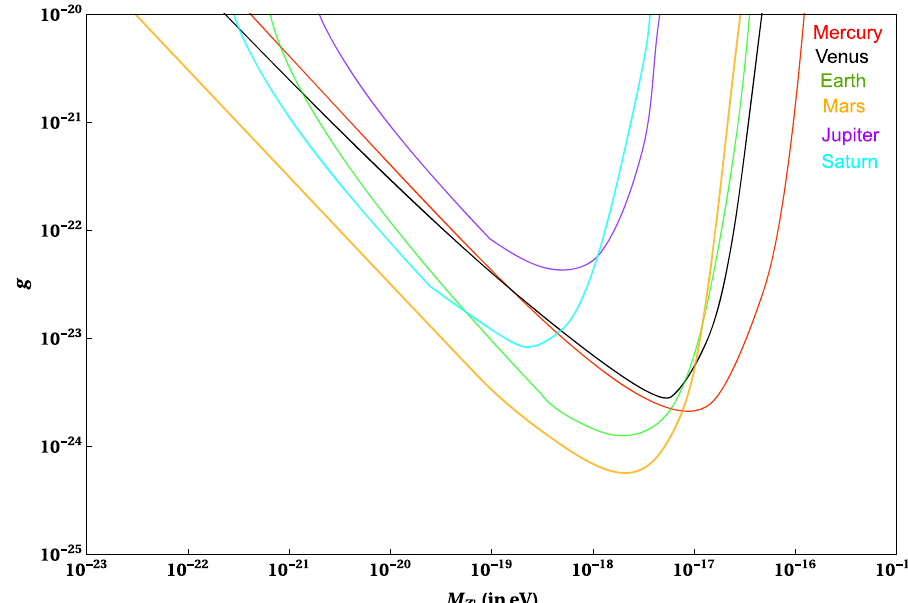
Fig. 3 Plot of the coupling constant g vs the mass of the gauge bosons M Z (cid:2) for all the planets. Here red, black, green, yellow, violet and cyan lines stand for the Mercury, Venus, Earth, Mars, Jupiter and Saturn